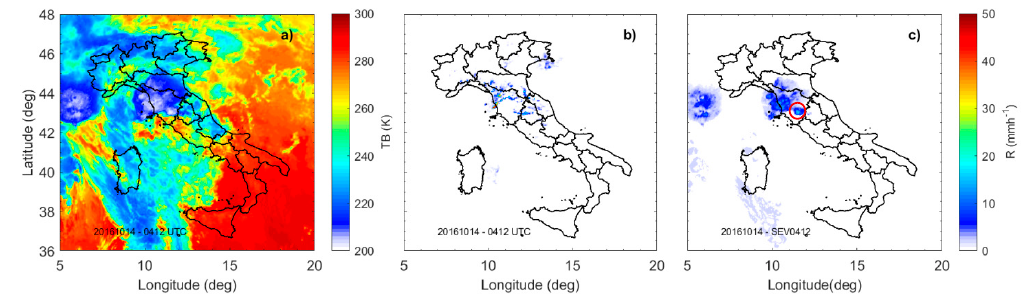
Figure 7. Snapshot relative to the 04:12 UTC of 14 October, 2016. Panel ( a ) shows the TB 10.8 as measured by SEVIRI, ( b ) the instantaneous rainfall rate as estimated by IT GR network at SEVIRI spatial resolution and ( c ) by RAINBOW.